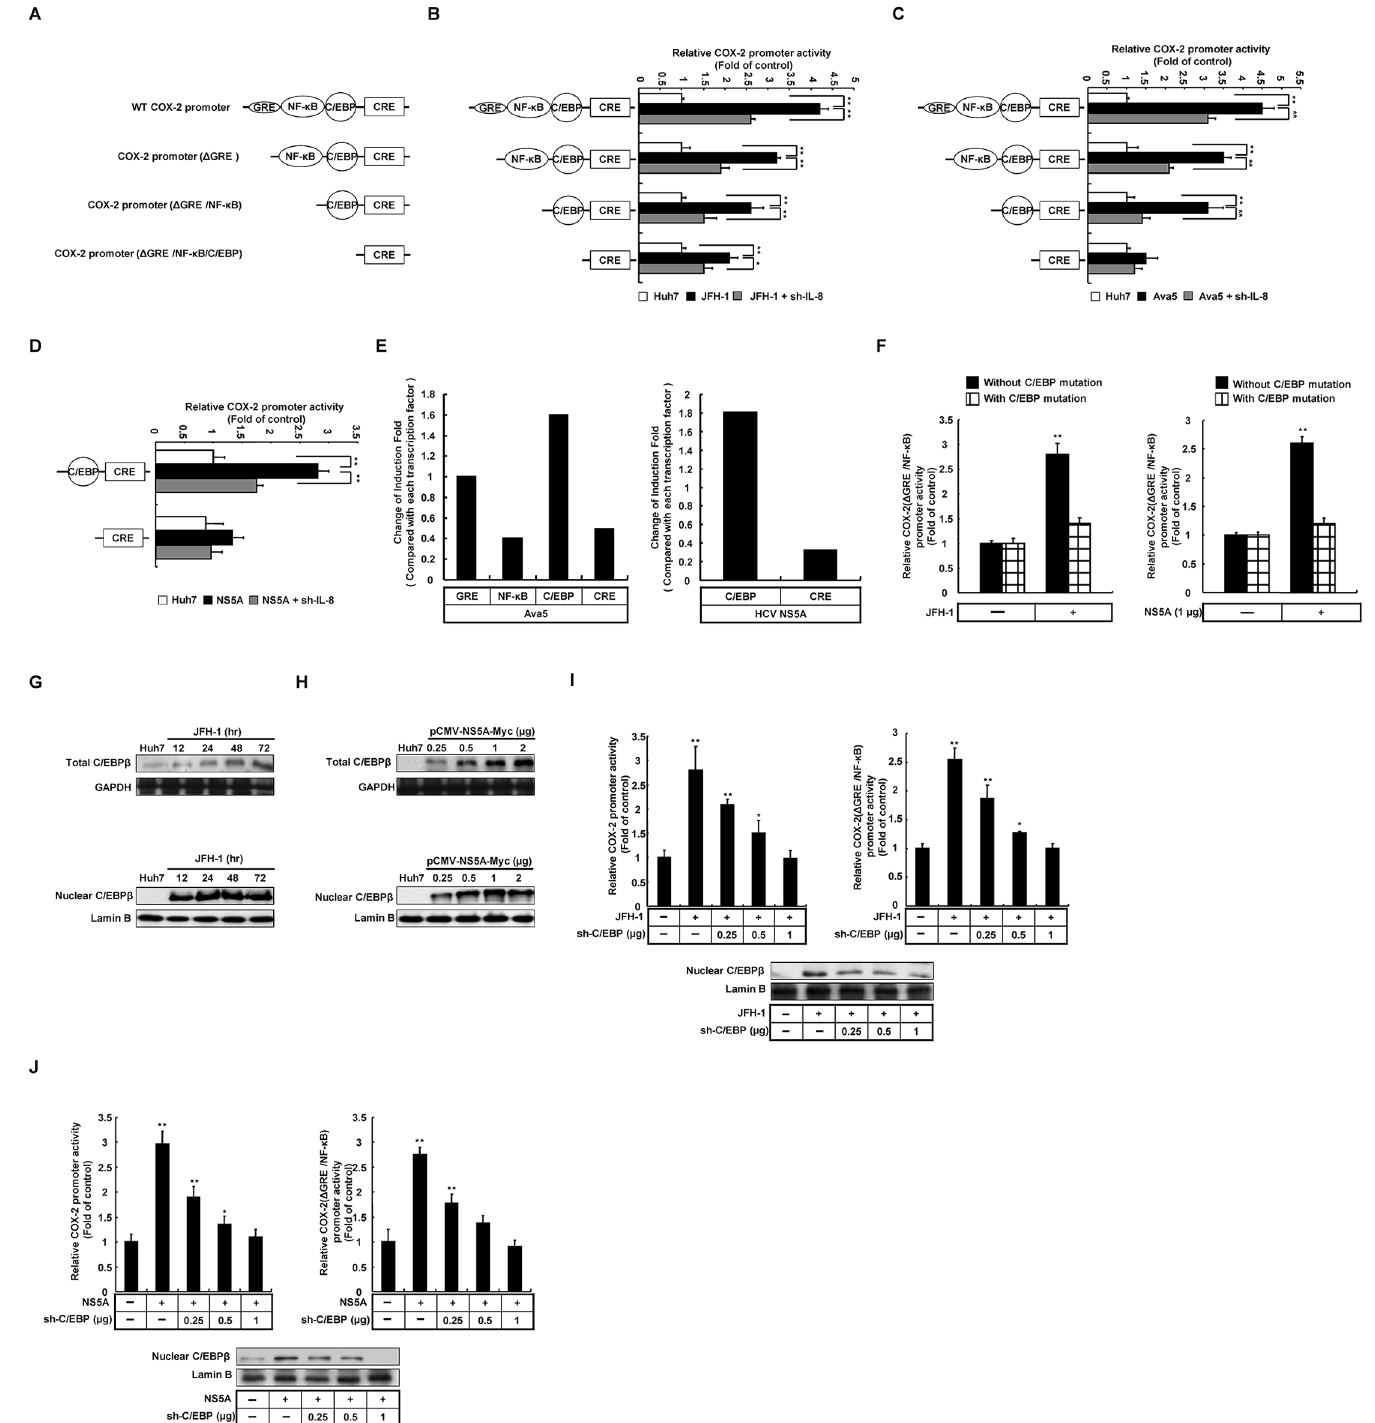
Fig 5. Determination of the effects of C/EBP on COX-2 expression regulated by HCV. (A) Diagrams of COX-2 promoter with series deletion containing binding element of transcription factor, which includes the wild-type COX-2 promoter (WT, − 891/+9) and series deletion ( Δ GRE, Δ GRE/NF- κ B, Δ GRE/ NF- κ B /C/EBP). (B, C) Huh7, JFH-1 infected Huh7, and Ava5 cells were co-transfected with each of the COX-2 reporter clones for analyzing the induction of COX-2 transcription factors. (D) The COX-2 reporter vector, pCOX-2( Δ GRE/NF- κ B)-Luc or pCOX-2( Δ GRE/NF- κ B/C/EBP)-Luc (1 μ g) was transfected into Huh7 cells with or without pCMV-NS5A-Myc. After 3 days of incubation, the cell lysates were subjected to the luciferase assay to measure the induction of COX-2 promoter activity. (E) The each transcription factor influenced induction fold change of COX-2 promoter in Ava5 cells or HCV NS5A-expression Huh7 cells.